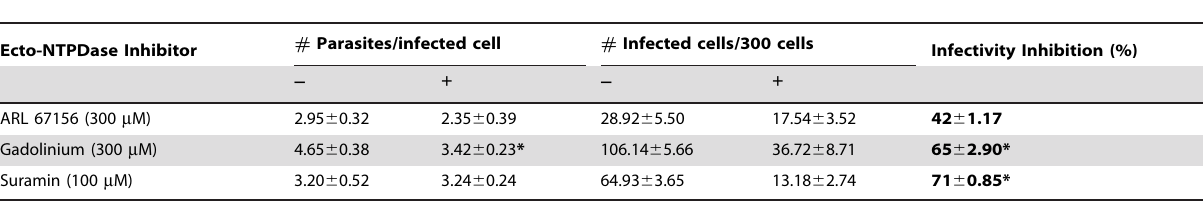
Percent inhibition of infection was calculated for each inhibitor assay relative to control data. Data reflect the mean 6 SE from three analyzed slides. Asterisks indicate significant differences (p , 0.05) between the control without inhibitor and the test with ATPDase